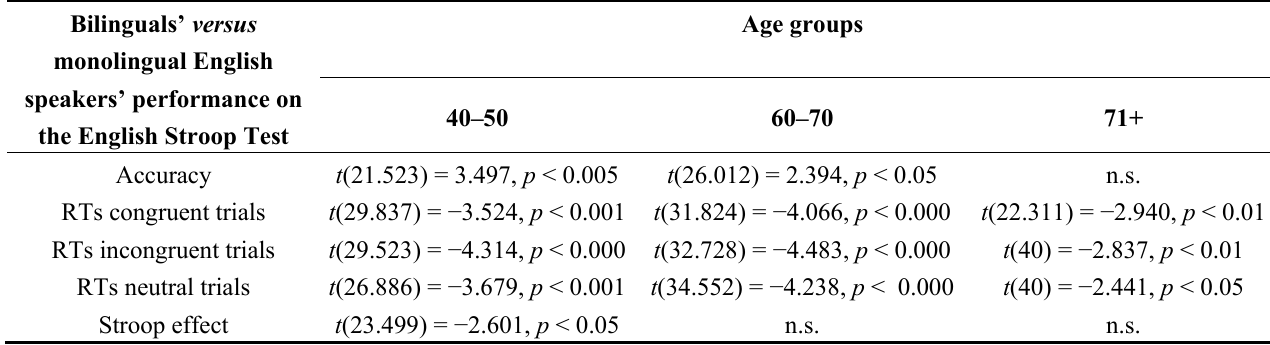
Table 7. Independent samples t -test statistics for the bilinguals versus English